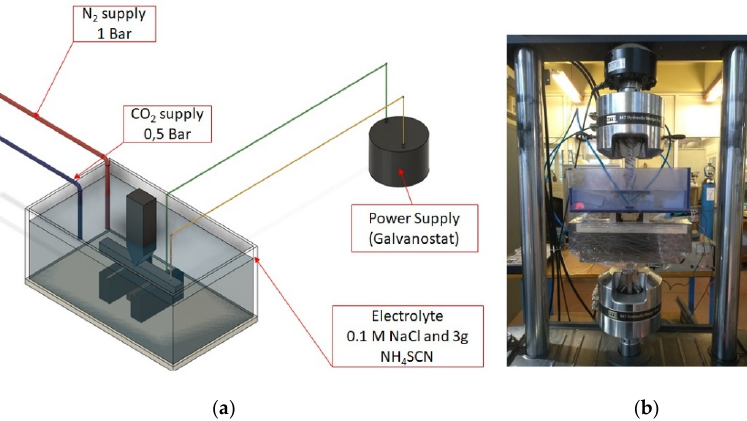
Figure 3. ( a ) Schematic illustration of the in situ hydrogen cathodic charging device, ( b ) Second stage of CTOD testing by the applicability of slow strain rate bending loading under in situ hydrogen cathodic charging conditions (polarization process).